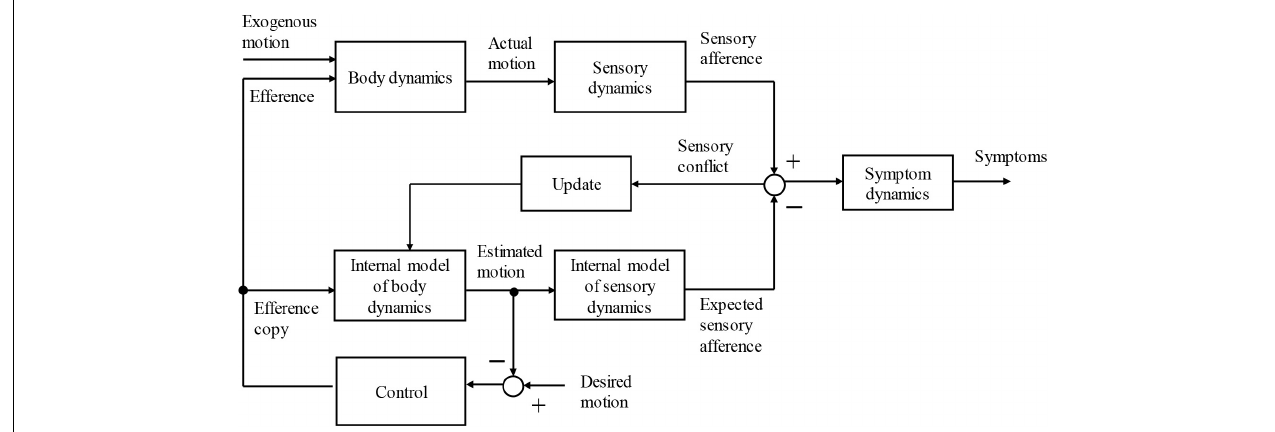
FIGURE 1 | Schematic block diagram of sensory conflict theory based on internal model